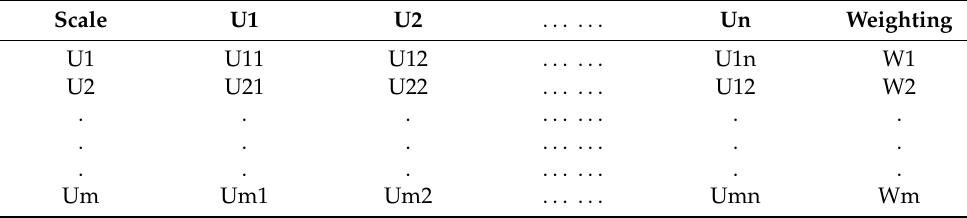
Table 2. Judgement matrix construction